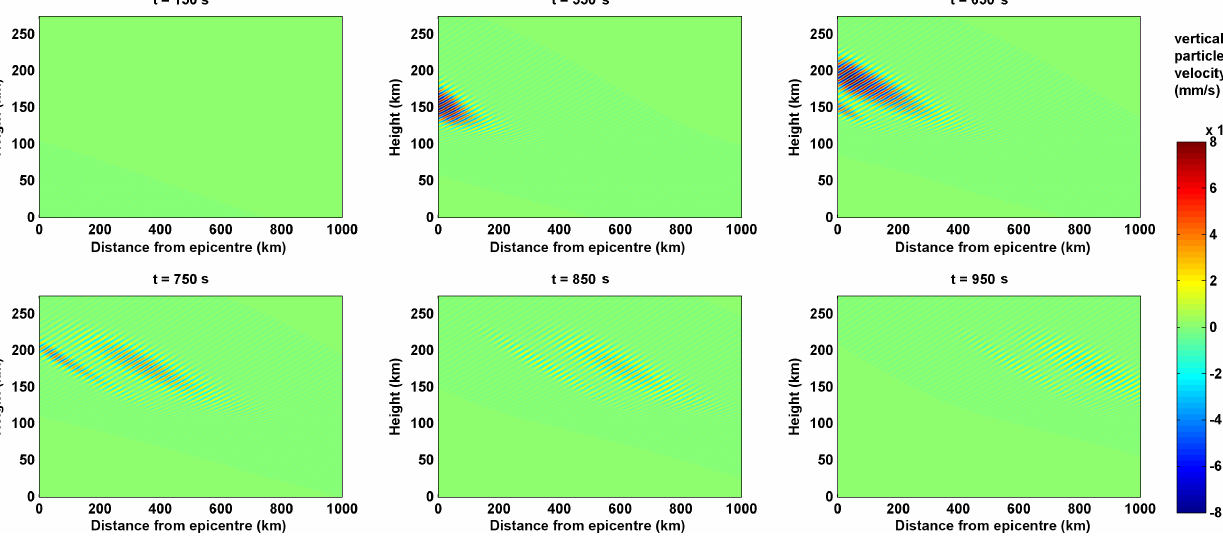
Figure 4. Snapshot of the infrasound propagation in the model at six different time intervals. It took around 300–400s for the infrasound to reach the bottom of the F layer. Two Gaussian wave packets of the infrasound can be seen. The amplitude of the infrasound vertical particle velocity can be seen decreasing as the distance from the epicentre increases, because the Rayleigh wave amplitude at the surface is considered to reduce as (r) − 1 / 2 , where r is the distance of a particular location from the